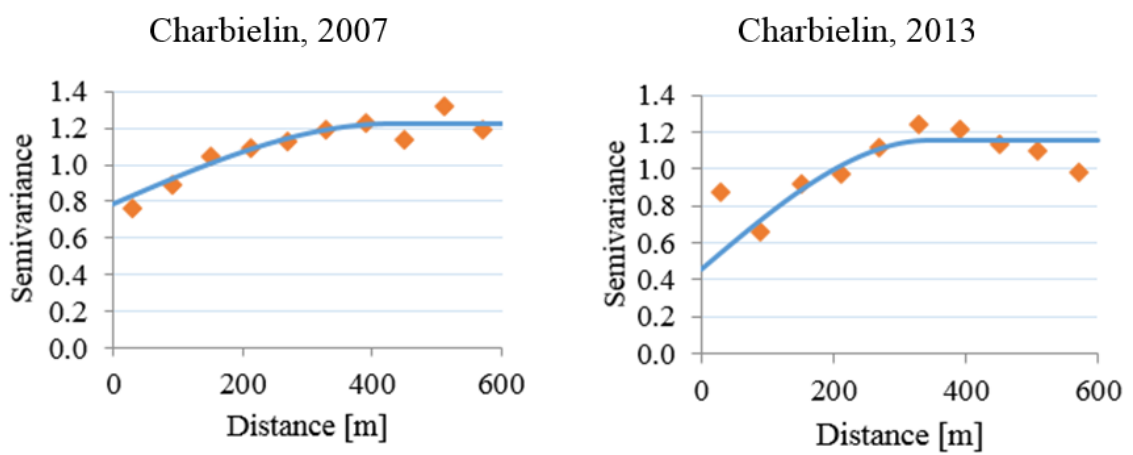
Figure 7: Semivariogram of the K contents in Charbielin (heavy soils) at the beginning (2007) and at the end of the experiment (2013).